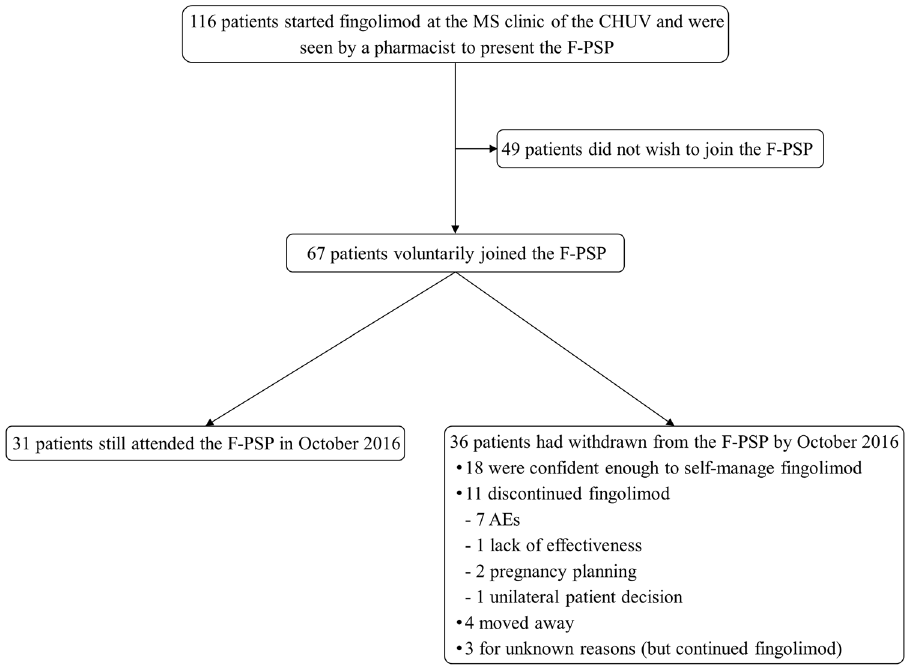
Figure 1. F-PSP status and number of patients over the 3-year observation period (Oct. 13 to Oct. 16); CHUV: Centre Hospitalier Universitaire Vaudois (Lausanne University Hospital); AE: adverse event; F-PSP: Fingolimod Patient Support Program; MS: multiple